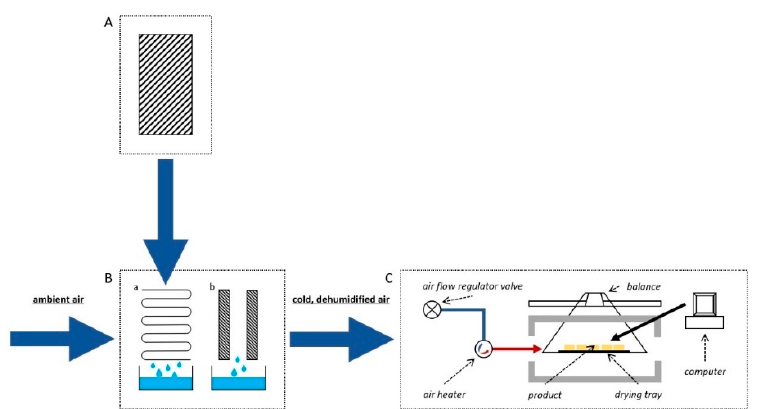
Figure 1. Scheme of drying equipment used in the study. ( A )–cooling unit; ( B )–dehumidification system which consist of a–condensation and b–adsorption parts; ( C )–dryer.